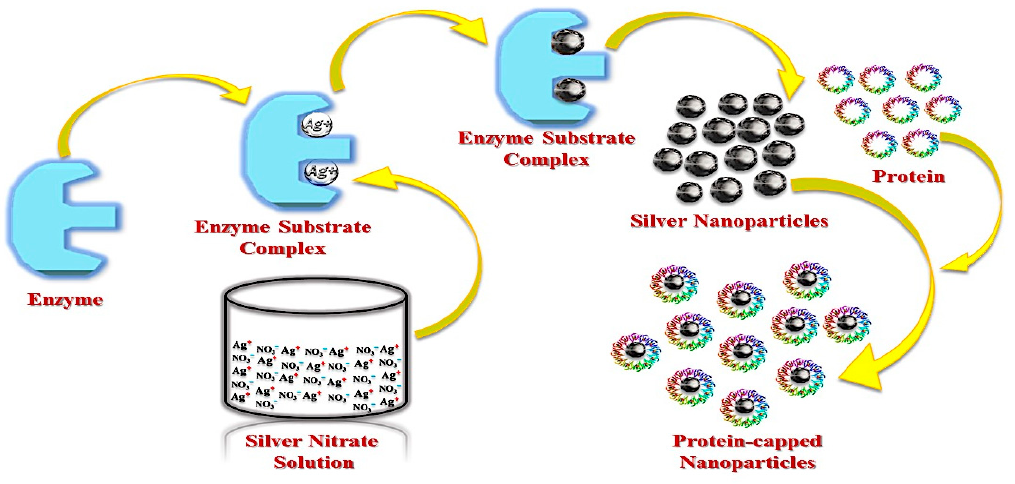
Figure 4. Fungal synthesis of AgNPs (modified from [60]).